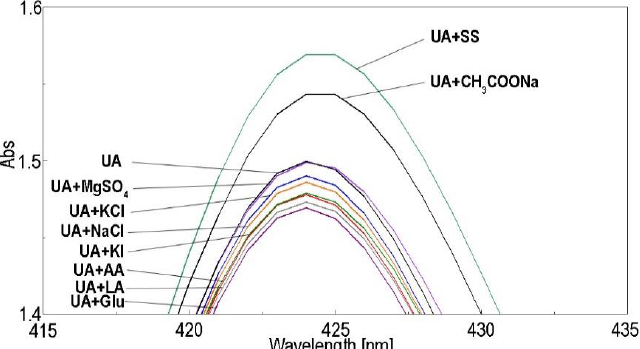
Figure 18. Overlapped UV-Vis spectra representing the influence of diverse interfering species: glucose (Glu), ascorbic acid (AA), NaCl, KCl, CH 3 COONa, MgSO 4 , KI, lactic acid (LA), sodium sa- licylate (SS), on the TAmPP-Pt@CuNPs hybrid complex at concentrations 1000-fold higher than UA.